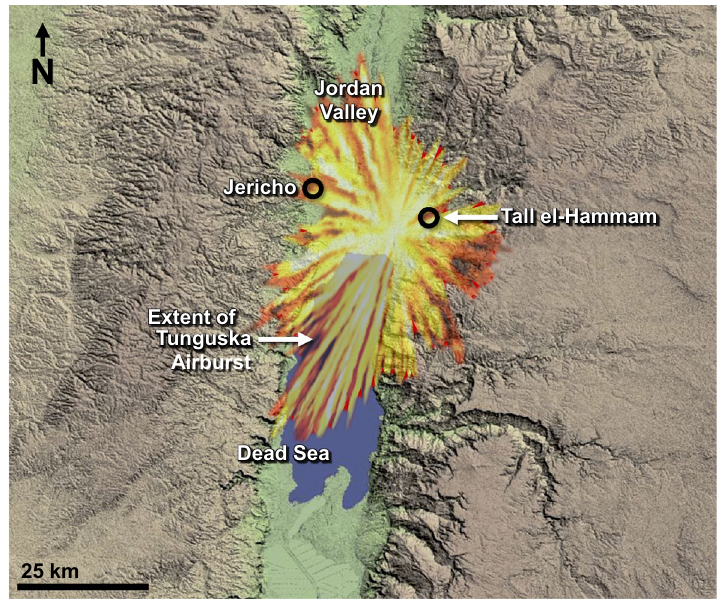
Figure 52. The extent of the cosmic airburst at Tunguska, Siberia (1908), superimposed on the Dead Sea area. The Tunguska blast was ~ 75 km wide N–S, affecting 2200 km 2 . This accurately scaled image shows that a cosmic airburst similar in energy to the one at Tunguska could cover a large segment of the Dead Sea and the Jordan Valley. Note that this overlay is for comparison only; the location, orientation, direction of travel, entry direction, and size of the proposed TeH impact is unknown. Source of base image: Shuttle Radar Topography Mission (SRTM) SRTMGL1 DEM of the Jordan Valley from February 2000 was obtained from https:// earth explo rer. usgs. gov/ maintained by the USGS/Earth Resources Observation and Science (EROS) Center, Sioux Falls, South Dakota, accessed on 4/4/2021. Modified by the authors using Adobe Photoshop CC2014 (adobe.